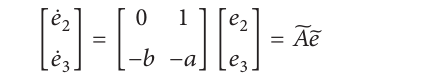
used to locate the image polar coordinates of tortuous blood vessel, as shown in Figure